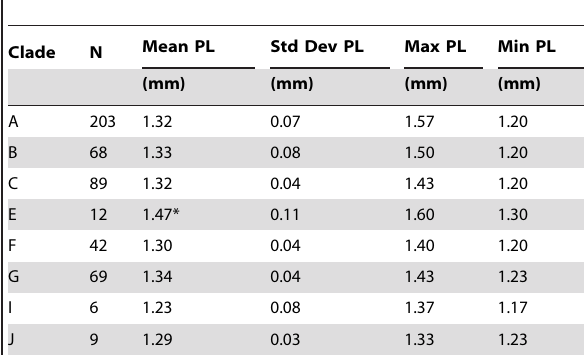
Table 3. Summary statistics of prosome lengths (PL) measured on genotyped P. piseki - P. gracilis specimens.